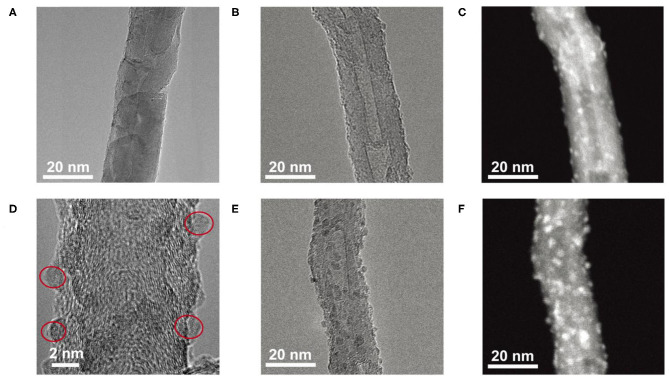
TEM images of 5Fe2O3/CNTs (A), TEM image (B), HAADF image (C), HRTEM image of 10Fe2O3/CNTs (D), HRTEM image (E), and HAADF image (F) of 15Fe2O3/CNTs.